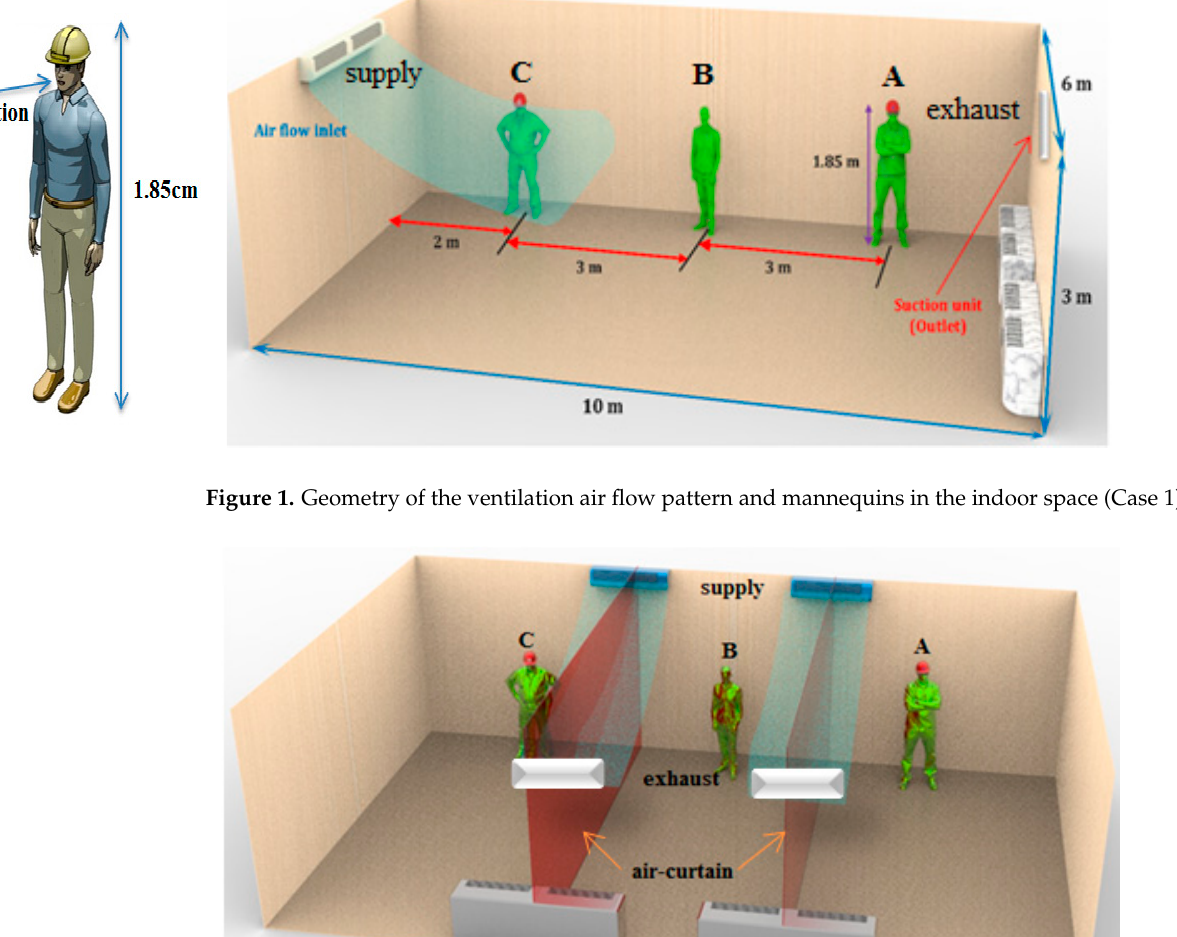
Figure 3. Top view of the indoor space. 2.2. Numerical Model 2.2.1. Boundary Conditions and Simulation We assume that one of the three 1.85 m tall persons infected with COVID-19 and standing in the indoor space shown in Figures 1 and 2 is coughing and emitting virus- infected droplets into the environment. In the first stage, the air flow is simulated for the steady ventilation flow in the room. Then respiratory droplets are introduced into the room space along with the air flow in six droplet groups (similar to the cough from a sick person’s mouth), and the simulation continues. In the simulation, we used the k- ε RNG model [3]. The RH in the cough air stream, the temperature in the cough air stream, the RH in this area, and the outside temperature are 100%, 37 °C, 50%, and 25 °C, respectively. The duration of the cough is 0.35 s, and the simulation of the dispersion of the droplets after their release continues for about 115 s. Ansys-Fluent (CFD) software was used in these simulations. The boundary conditions of the air flow are shown in Table 1. A user- defined function (UDF) is applied at the mouth to generate the time-varying velocity in the cough air flow rate. The time-varying air flow velocity during coughing is modeled as a combination of gamma functions. Based on the experimental study of Gupta et al. [12], the maximum air velocity of coughed droplets is 12.1 m/s. Droplet evaporation can play an essential role in the spread of COVID-19 with two effects. First, changing the size of the droplets during evaporation affects the movement and retention time of the droplets in the gaseous phase. Second, the compounds in the droplet, including water and some other compounds, affect the survival of the virus. A UDF is applied for the evaporation of droplets in the cough air flow rate [13]. According to Table 2, cough drops coming out of the mouth are divided into six groups [4] (see Table 2).